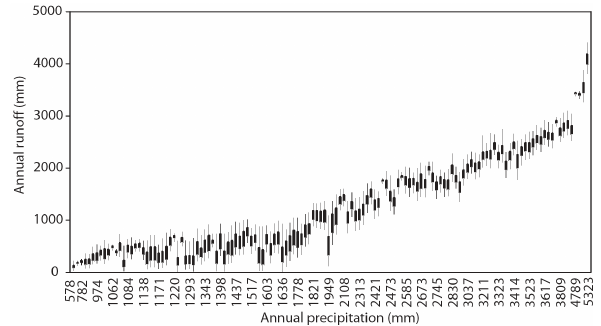
976 Fig. 6. MAPSS model runoff uncertainty obtained by a Monte Carlo-type approach (Latin Hypercube Sampling). For each catch- ment, the black line shows the whole range of predicted values and the box ranges within one standard deviation from the mean. Catch- ments were ordered according to annual precipitation. (Horizontal axis does not show all catchment